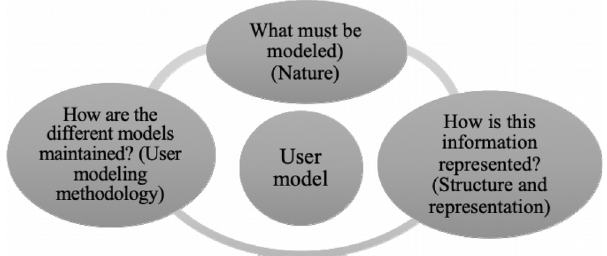
Figure 4. Brusilovsky and Maybury’s (2007) proposed user model